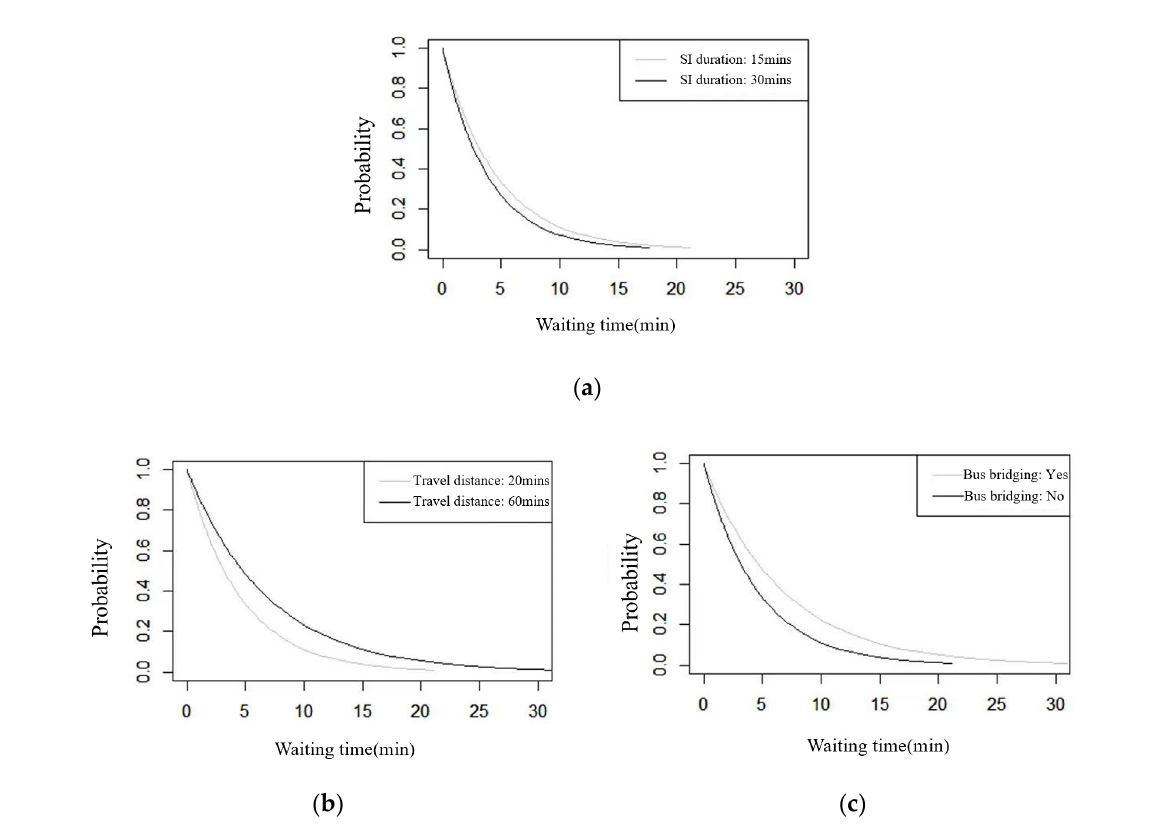
Figure 3. Survival curves of different passengers. ( a ) passenger #1 vs. #2. ( b ) passenger #3 vs. #4. ( c ) passenger #5 vs.